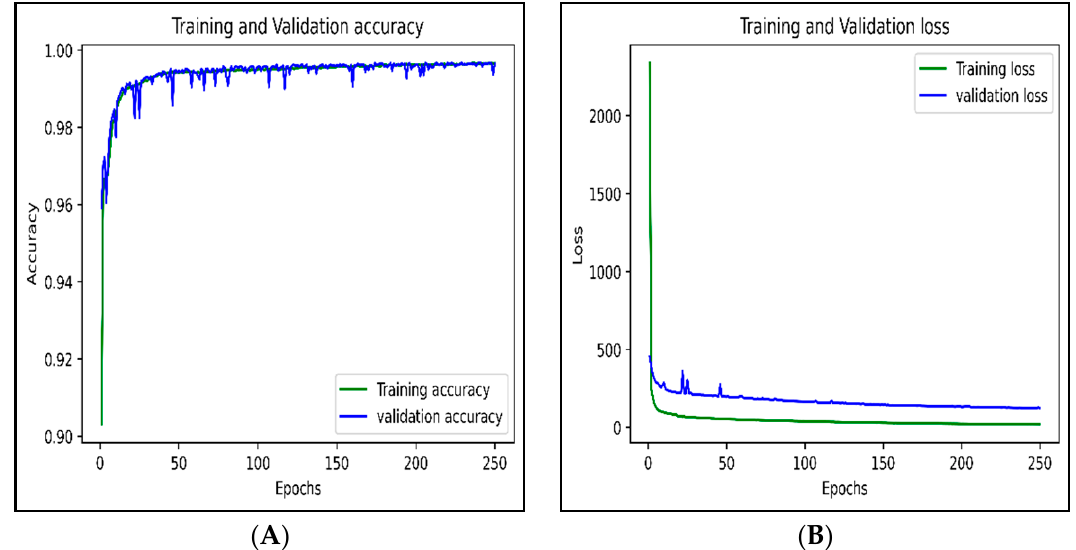
Figure 21. ( A,B ): Accuracy and Loss curves for Friday afternoon PortScan sub-dataset. Figure 21. ( A , B ): Accuracy and Loss curves for Friday afternoon PortScan